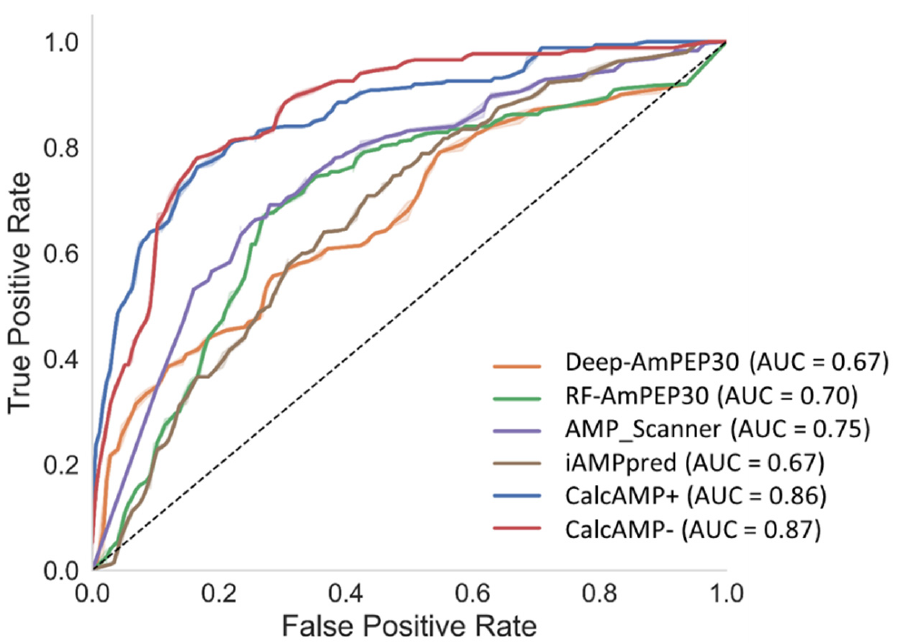
Figure 8. Receiver operator characteristic (ROC) curves of the different AMP classifiers and their area under the curve score.